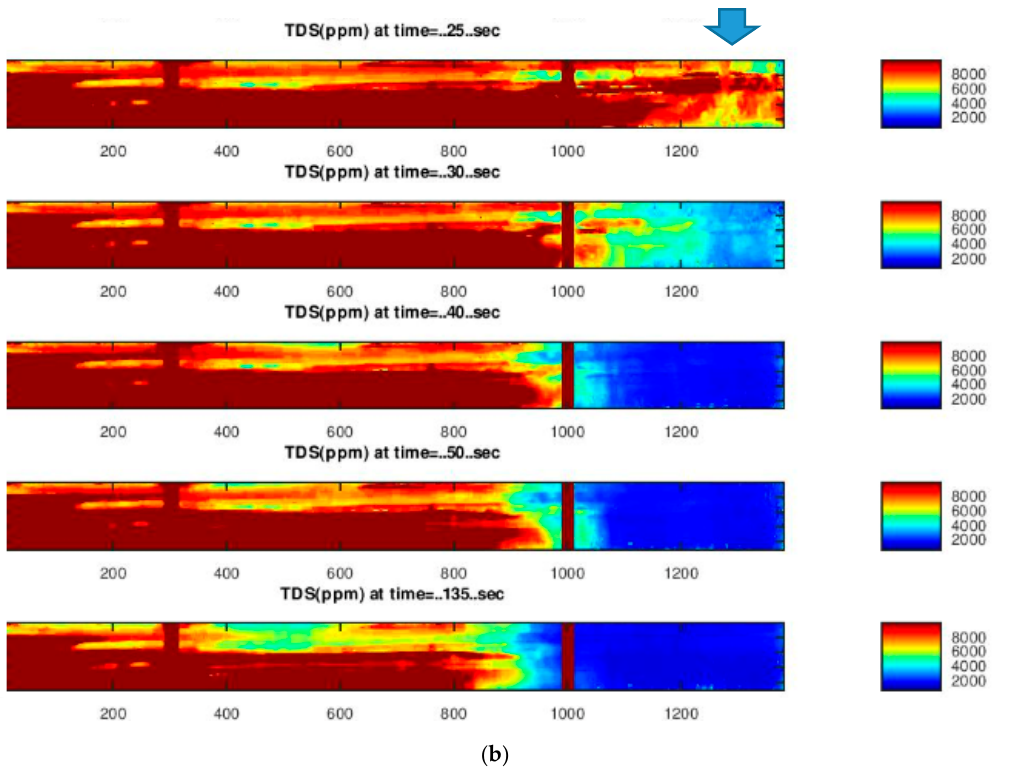
Figure 9. ( a ) Temporal Reduction of TDS (Run#20, Xp/D = 11) and ( b ) color maps for TDS variation with the course of time (Run #20, Xp/D = 11).